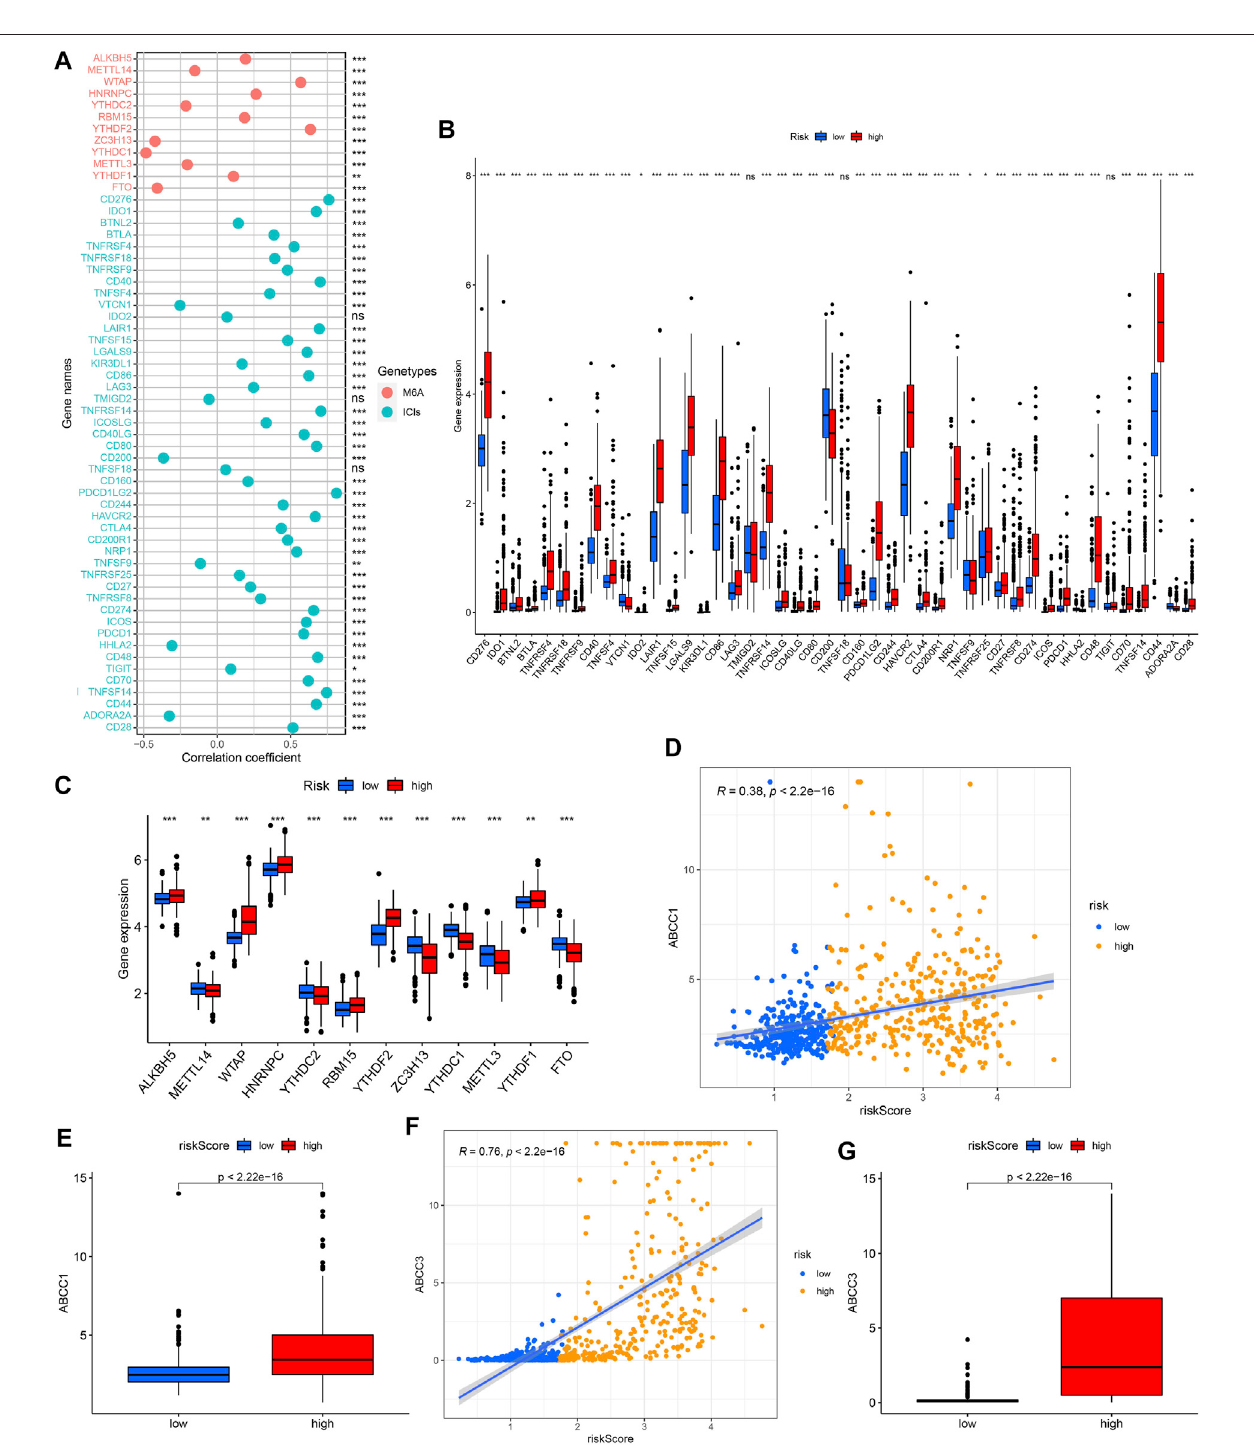
FIGURE14| CorrelationanalysisbetweenriskscoreandICIs-relatedgenes/m6a-relatedgenes/multidrugresistancerelatedgenesexpression,andcomparisonof them between different risk groups. (A , B) ICIs-related genes. (A , C) M6a-related genes. (D , E) ABCC1. (F , G) ABCC3.